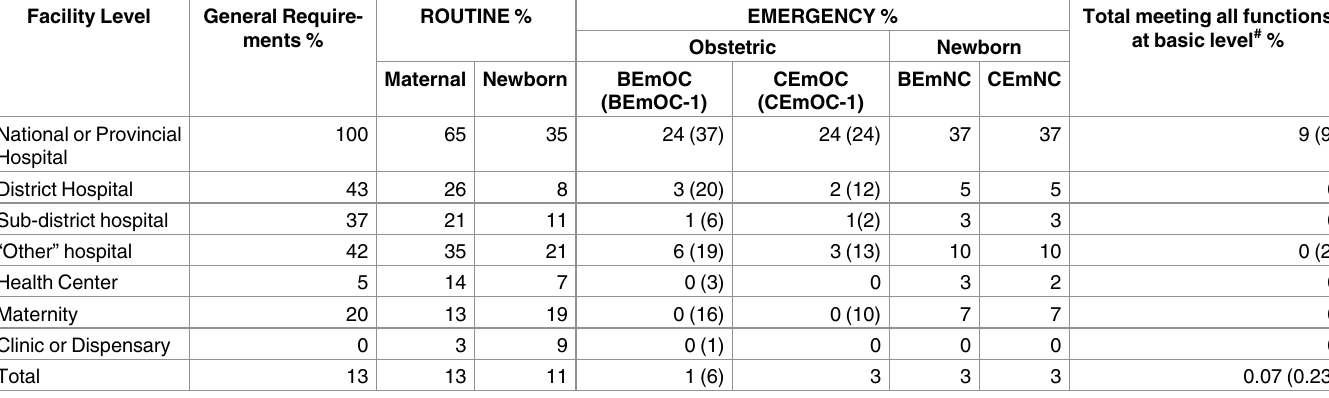
Table 5. Availability of general requirements and facility capability of routine and emergencychildbirth care, by facility